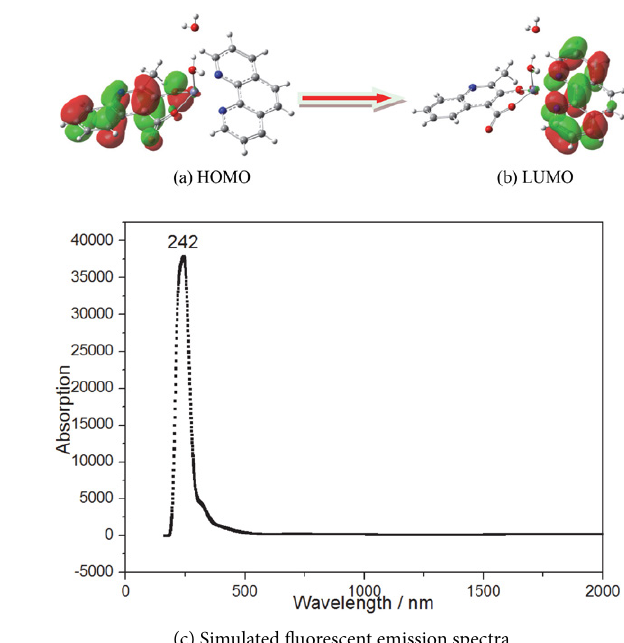
(c) Simulated fluorescent emission spectra Fig. 7. (a) HOMO and (b) LUMO (with isosurface of 0.003) and TD-DFT simulated fluorescent emission spectra of the title